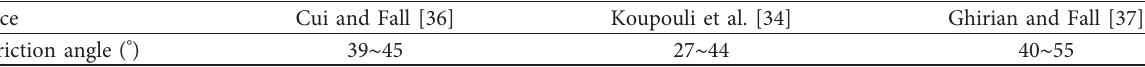
Table 2: Measured data of internal friction angle of CPB.